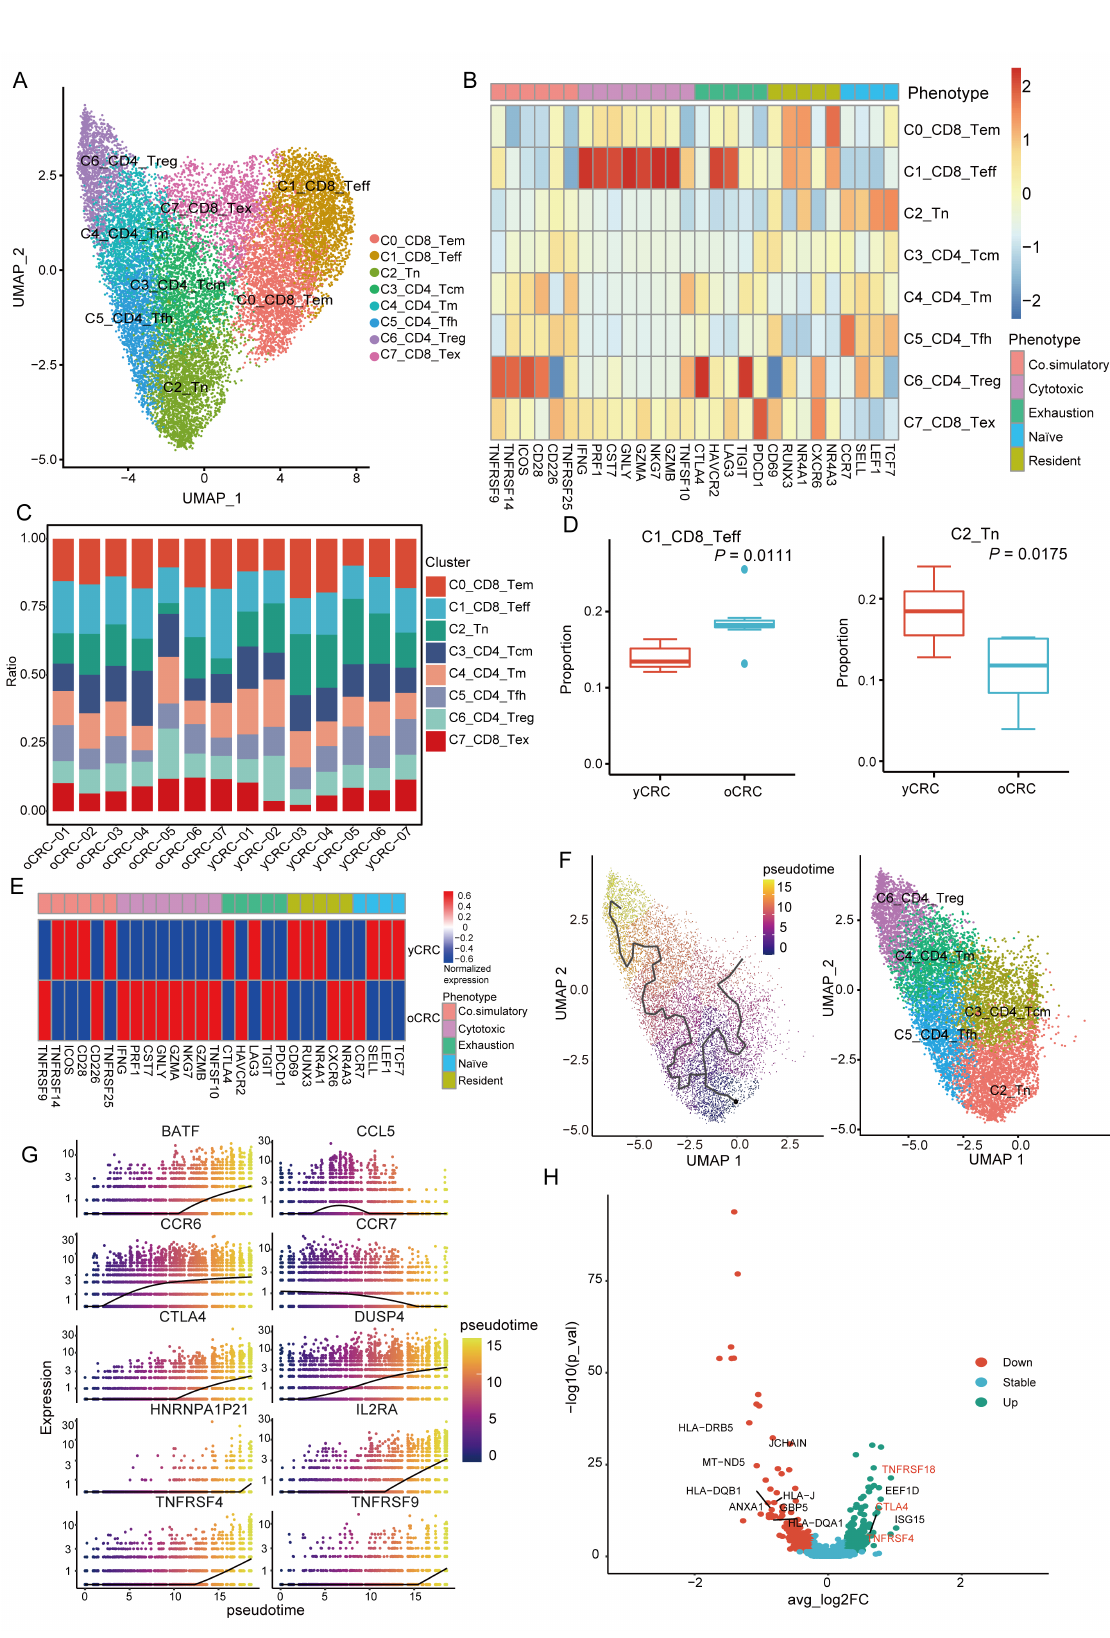
Figure 2. Features and heterogeneity of T cell subtypes in yCRC and oCRC. ( A ) UMAP plot showing the subgroups of T cells. ( B ) Heatmap showing expression of T cell functional phenotype genes in different T cell subtypes. ( C ) The bar chart showing the proportion of T cell subtypes in different patients. ( D ) Comparison of selected T cell subtype populations between yCRC and oCRC. ( E ) Heatmap